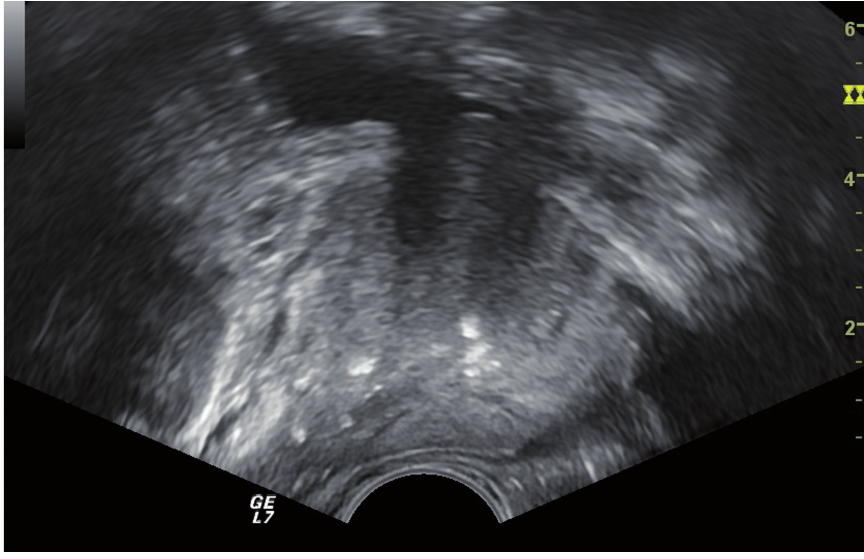
figure 2 - Transrectal ultrasound in longitudinal section of prostate shows mild calcifications with 1 or multiple small foci without coarse